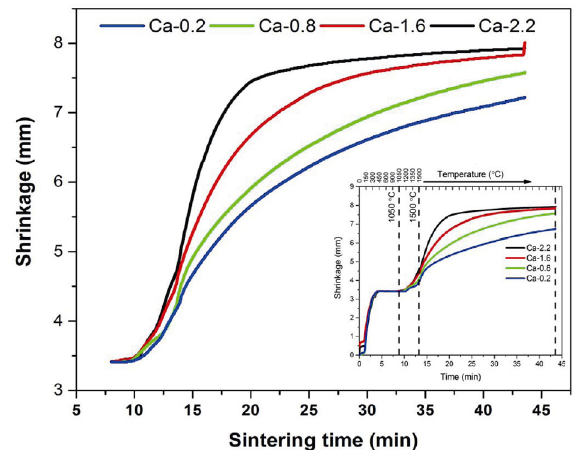
Fig. 3 Densification curves of several compositions of calcium stabilized nitrogen rich sialons synthesized at 1500 ℃ using SPS technique, where Ca content varies between 0.2 and 2.2. The inset shows the complete densification curves and the main plot represents the selected high-temperature region (heating from 1050 to 1500 ℃ followed by 30 min holding